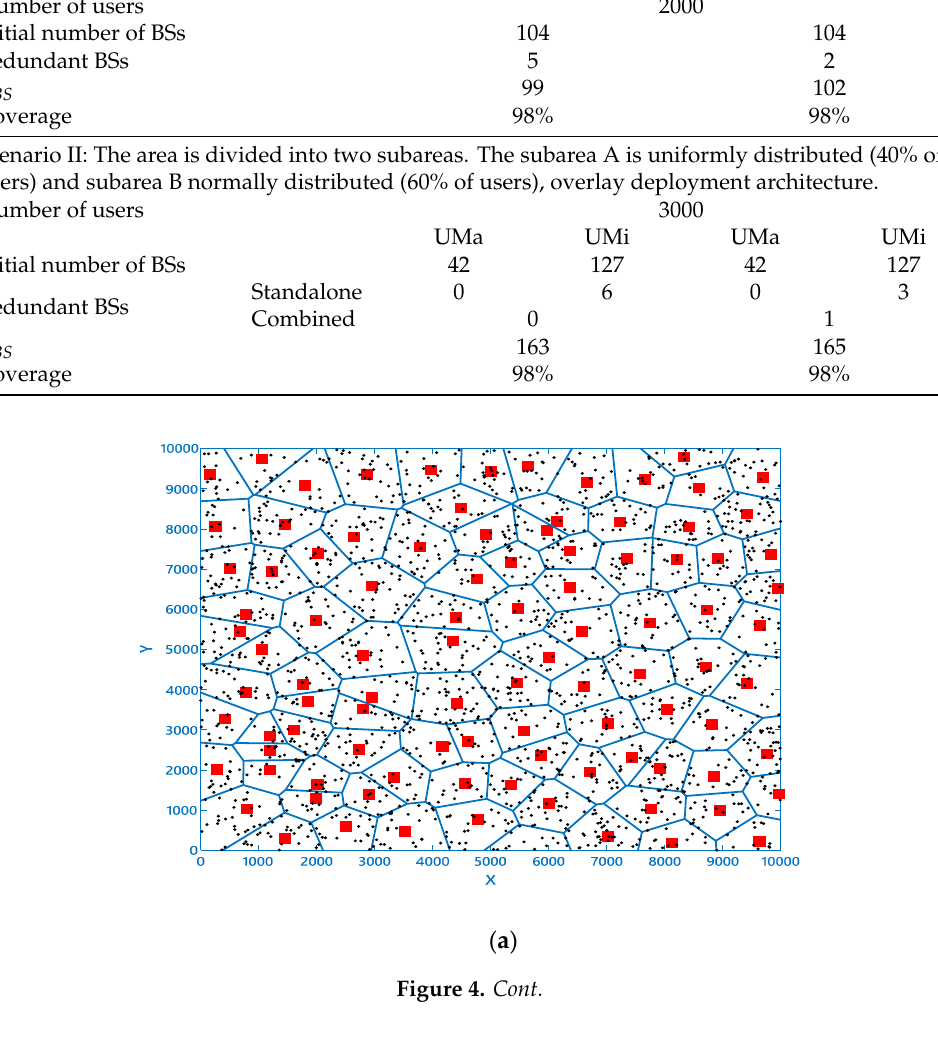
Table 3. Summary of important simulation parameters for PSO and simulated annealing (SA).